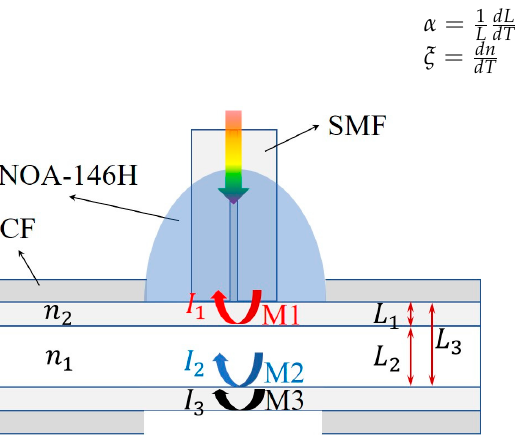
Figure 1. HFP sensor structure schematic.